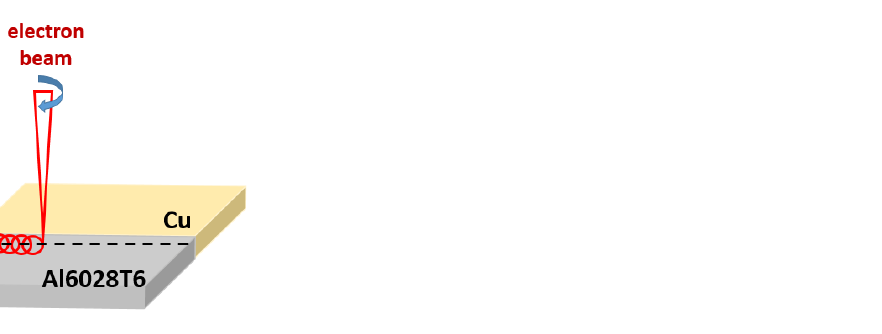
Figure 1. Scheme of the experiment of the EBW process of pure copper and aluminum alloy Al6082T6 with beam offsets toward the aluminum alloy’s side.